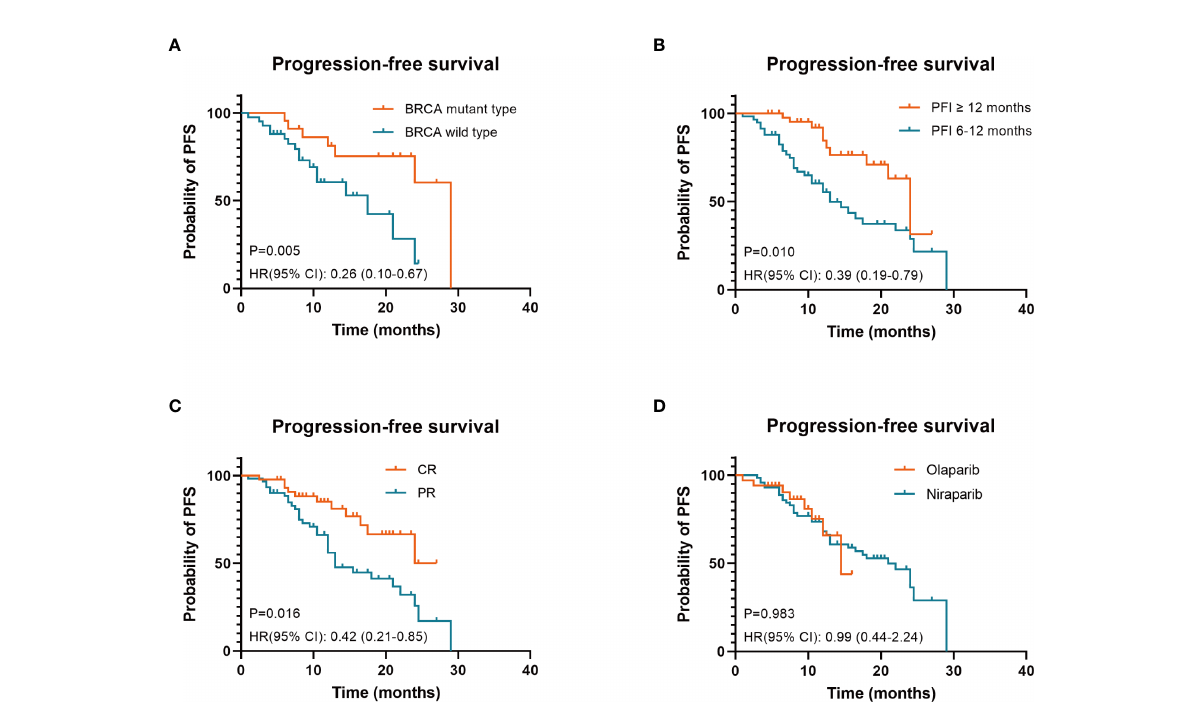
FIGURE 2 Three factors associated with prolonged progression-free survival (PFS) under PARP inhibitors in patients with platinum-sensitive recurrent ovarian cancer were identi fi ed: BRCA mutant type (A) , PFI ≥ 12 months (B) and CR to last platinum-based therapy (C) . PARP inhibitor regimen